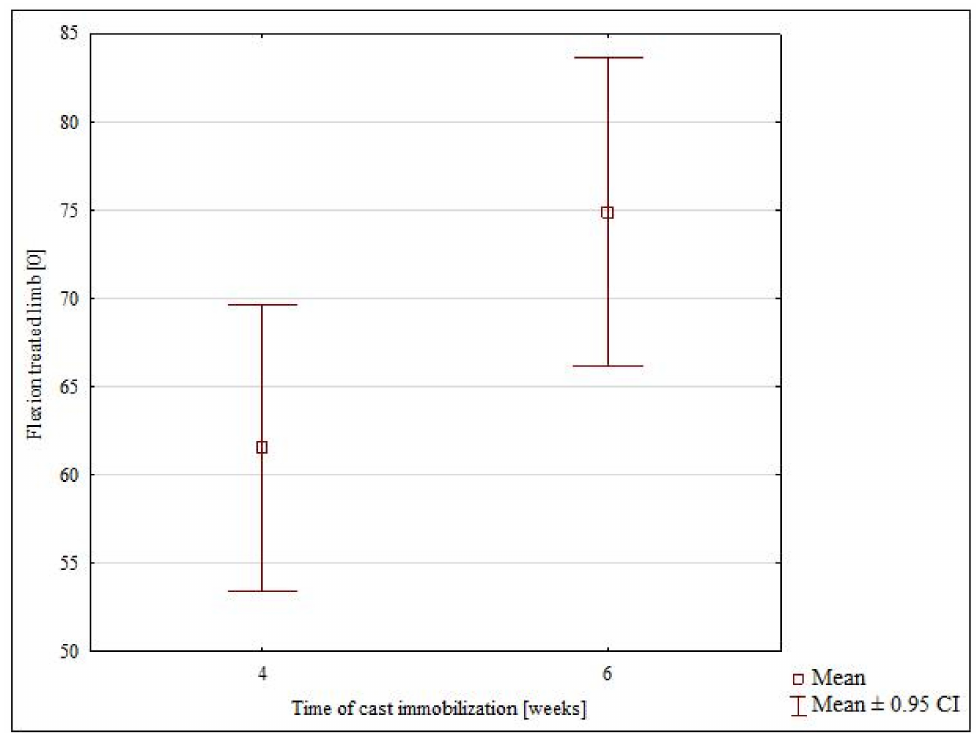
Figure 4. The range of flexion in the 4-weeks and 6-week